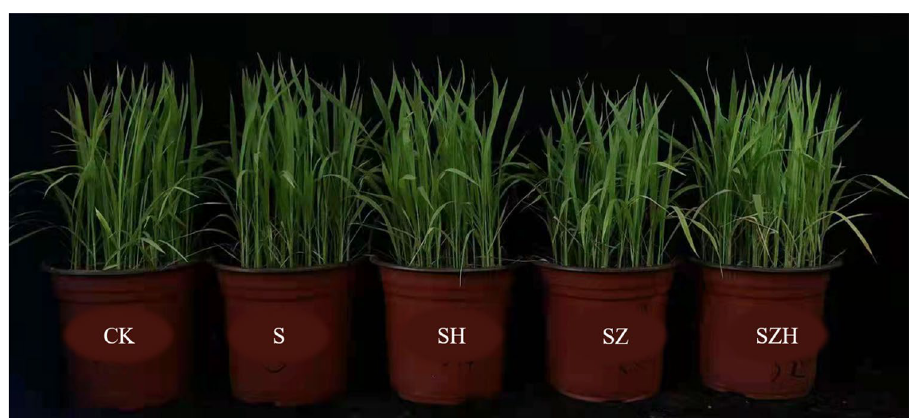
Figure 2. Effects of Hemin on the growth of rice seedlings under NaCl stress (5 d) in XLY900. CK: 0 mM NaCl + 0 μmol·L −1 Hemin, S: 50 mM NaCl + 0 μmol·L −1 Hemin, SH: 50 mM NaCl + 5 μmol·L −1 Hemin, SZ: 50